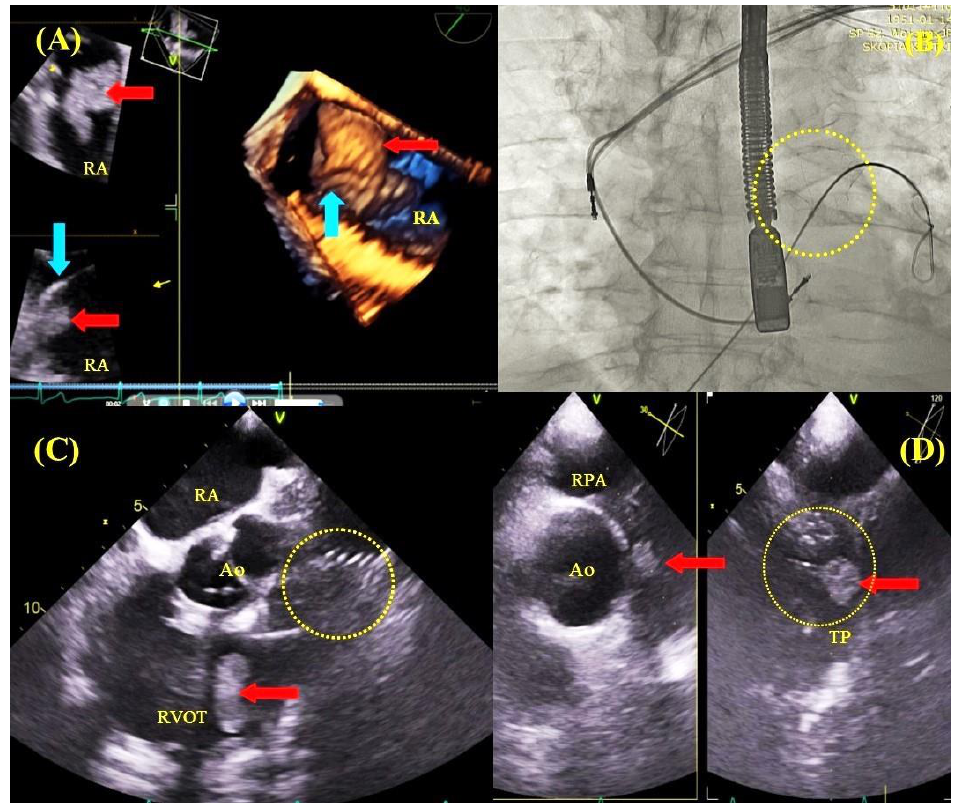
Figure 7. TLE in the course of lead-related infective endocarditis with pulmonary embolization protection devices and TEE guidance. 2D and D TEE images–a vegetation 4.0 × 1.7 cm in size (red arrow) on the ventricular lead (blue arrow) in the right atrium ( A ). Fluoroscopy–a nitinol basket (yellow circle) positioned within the pulmonary artery (pulmonary embolization protection), pulling on both leads (lead-to-lead adhesion) during atrial lead extraction ( B ). TEE images–mid-esophageal view, dislodgement of the vegetation (red arrow) into the RVOT after removal of the ventricular lead ( C ). TEE images–upper esophageal view (Multi D imaging), vegetation fragment captured by the basket in the pulmonary artery ( D ). However, it should be emphasized that there were no periprocedural deaths among TEE-guided patients, whereas six patients died among the non-TEE-guided